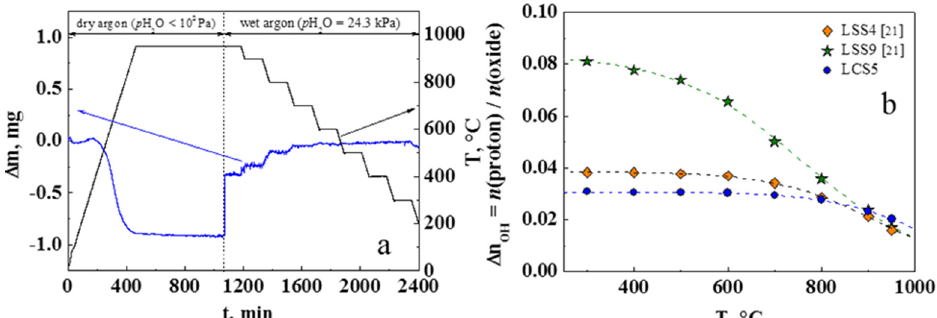
Figure 6. TGA results for lanthanum scandates: ( a ) Weight change of the LCS5 during hydration; ( b ) the temperature dependence of the proton concentration for LCS5 and comparison with literature data for strontium doped lanthanum scandates [21], p H 2 O = 24.3 kPa. Symbols correspond to the concentrations obtained from the TGA data and dashed lines are the fitting curve.